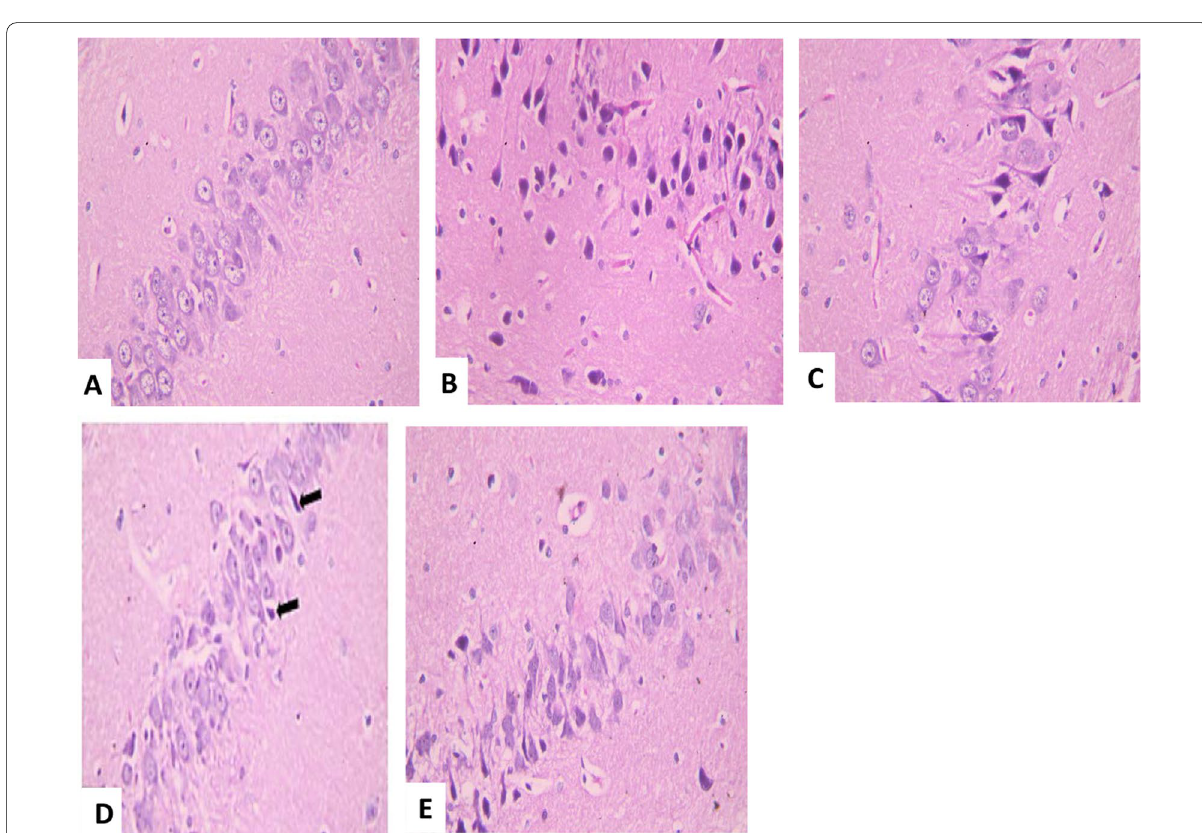
Fig. 1 H&E stained sections of hippocampus (CA3) region. A Control non ketamine treated rats showed pyramidal layer is formed of large pyramidal cells having vesicular nuclei. B Ketamine treated rats showed many shrunken pyramidal cells with dark cytoplasm and pyknotic nuclei.